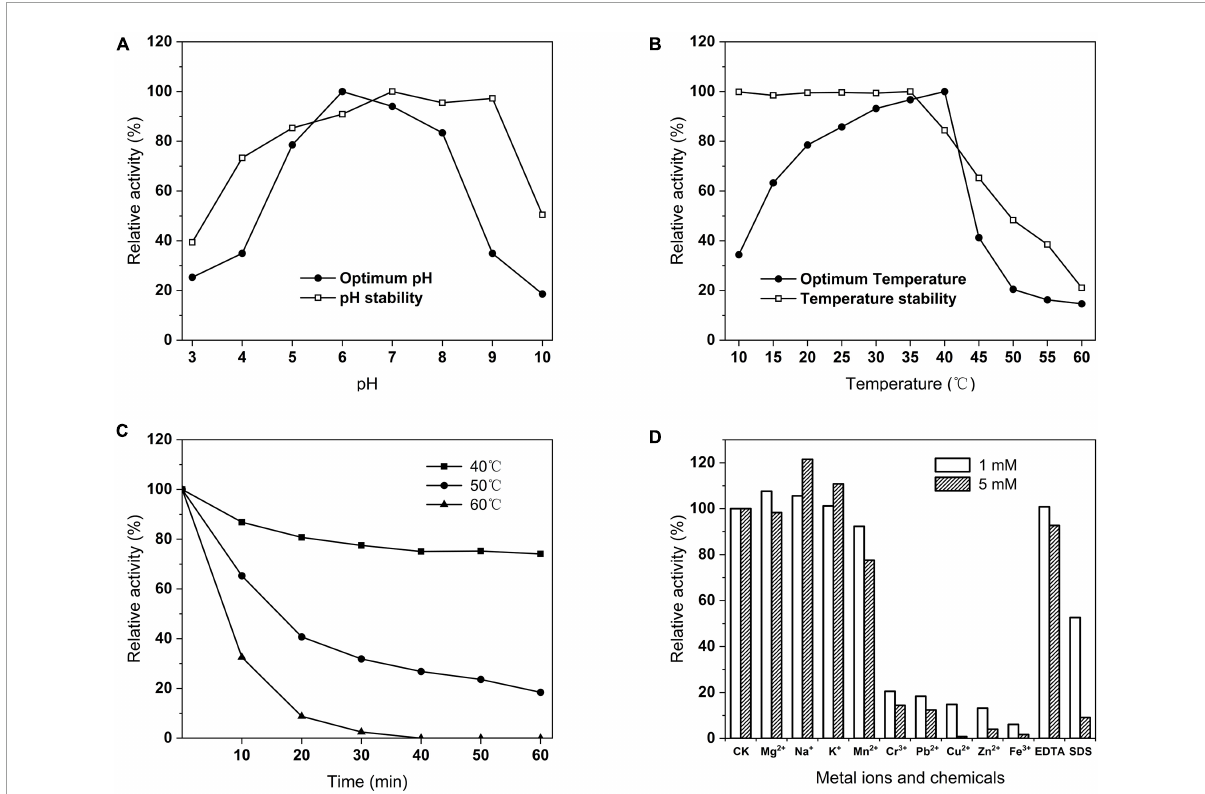
FIGURE8 (A) Optimum and stability of pH on PHY101 activity from 3.0 to 10.0. (B) Optimum and stability of temperature on PHY101 activity from 10 to 60 ◦ C. (C) Thermal stability on PHY101 activity by different temperatures from 40 to 60 ◦ C for 10–60 min. (D) Effect of metal ions and chemical reagents on PHY101 activity. Each value is a mean of three independent